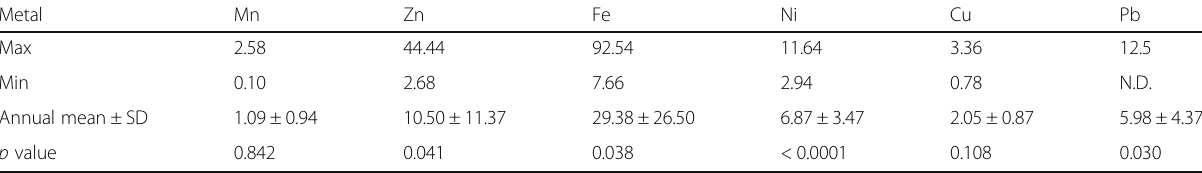
Table 3 Descriptive statistics of heavy metal values ( μ g/L) in the surface water of Burullus Lake during